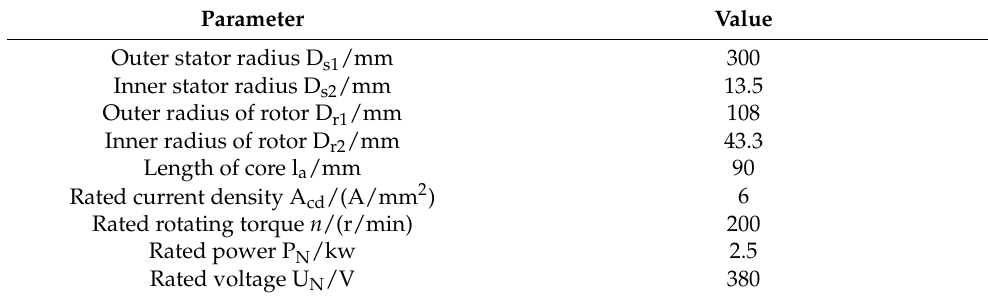
Table 1. Main parameters of DSRM.